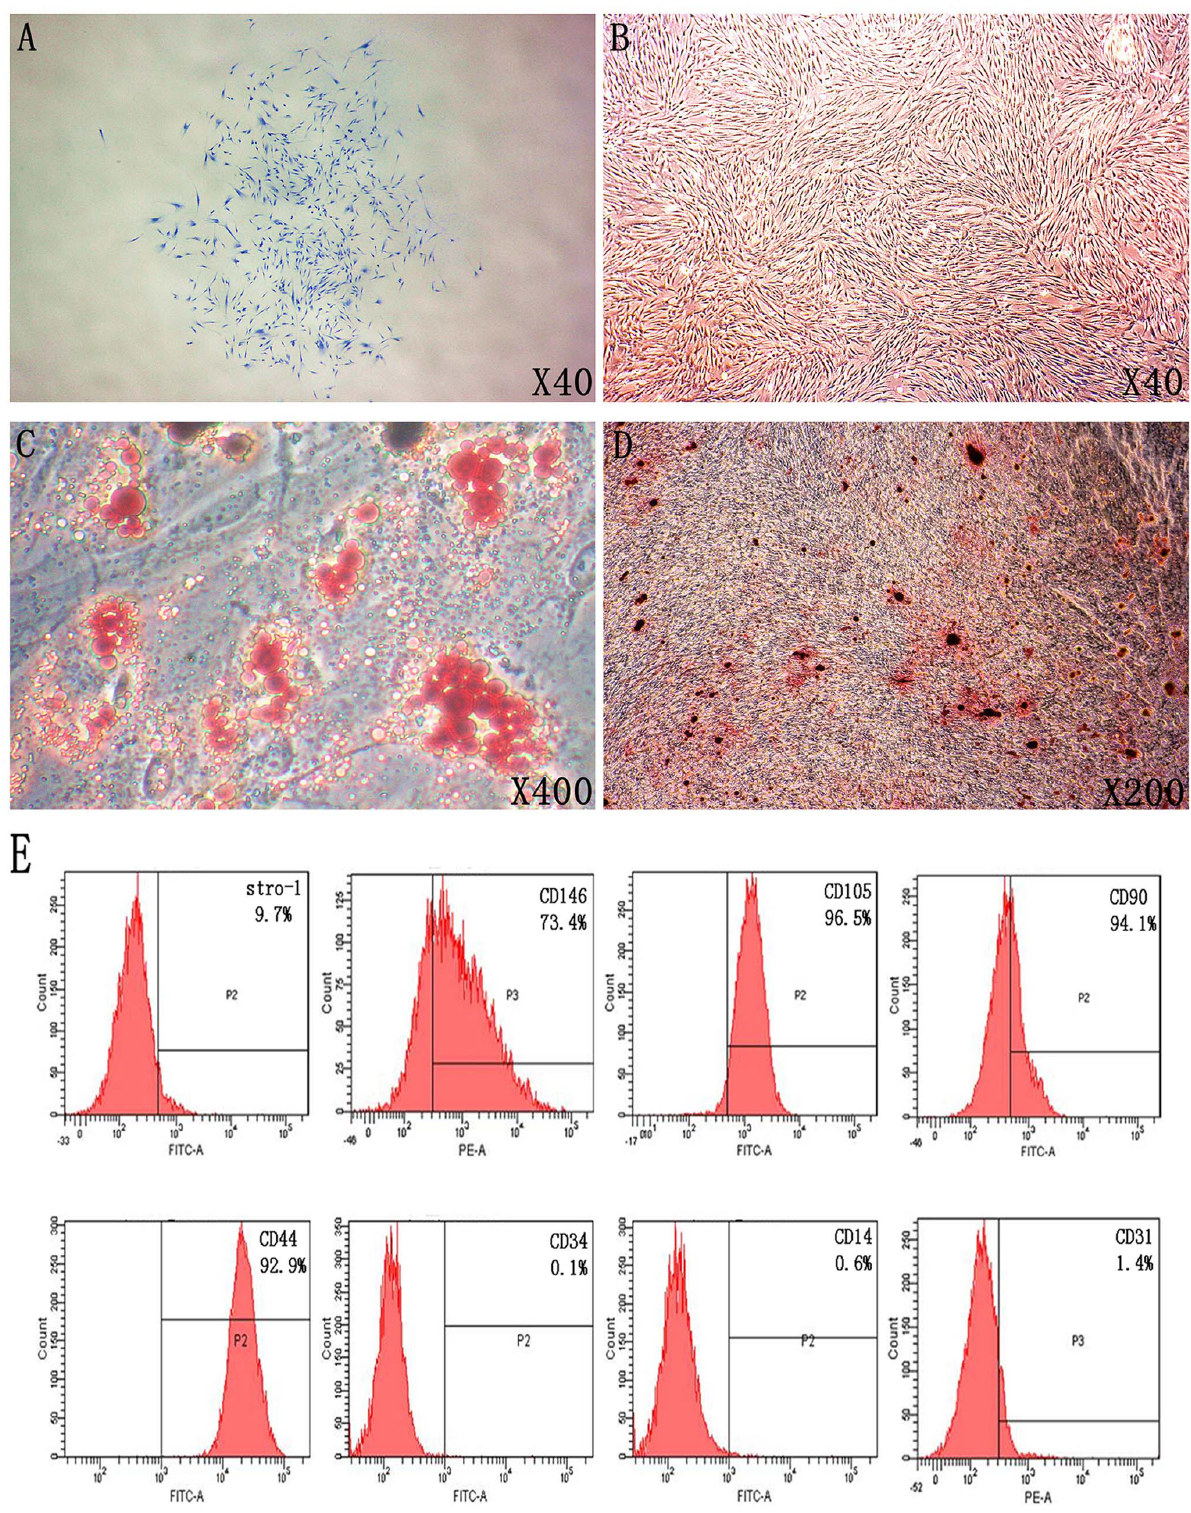
Figure 1. Isolation and identification for human periodontal ligament stem cells. A : Colonies derived from single cell in the method of limiting dilution was picked up for further culturing of hPDLSCs; B : hPDLSCs were grown in culture medium with a long spindle shape; C : Adipogenic differentiation of hPDLSCs was determined by Oil red O staining after 21 days of adipogenic induction; D : Osteogenic differentiation of hPDLSCs was determined by Alizarin red S staining after 21 days of osteogenic induction; E : Immunophenotype analysis of PDLSCs was determined by Flow cytometry assay.